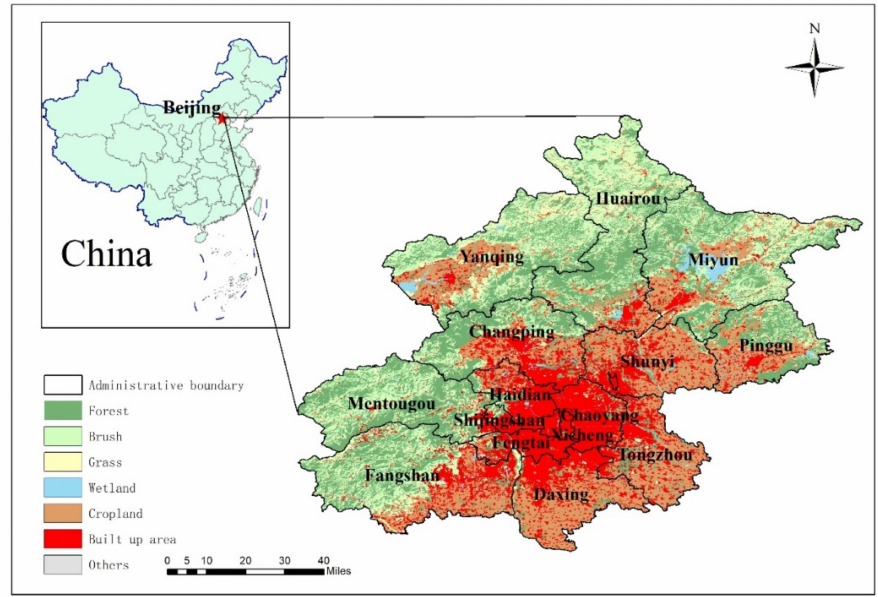
Figure 1. Landscape of Beijing city and administrative